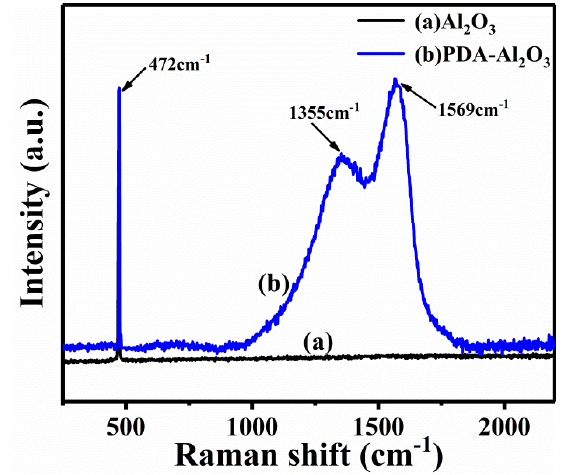
Figure 6. Raman results for Al 2 O 3 and PDA-Al 2 O 3 .